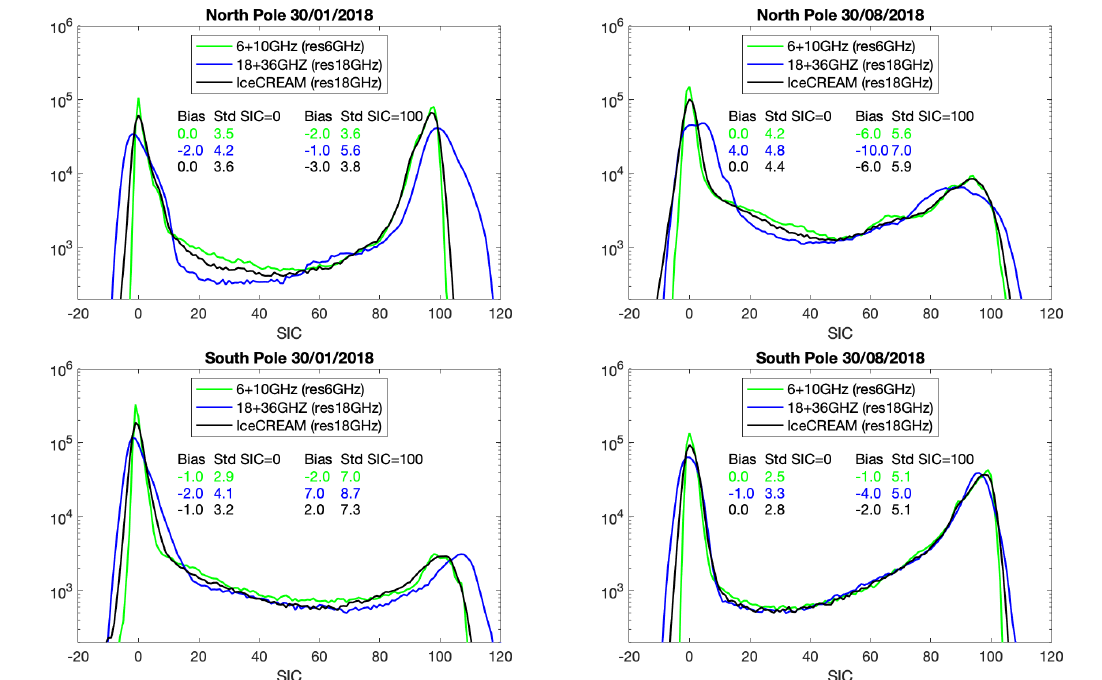
Figure 11. Histograms of our SIC estimates, for the north (top) and the south (bottom) polar regions, for 30 January 2018 (left), and for 30 August 2018 (right), for the 6+10GHz, the 18+36GHz, and the IceCREAM algorithms. A logarithmic scale is used for the y-axis. For SIC at 0% and SIC at 100%, the bias and the std are indicated for each algorithm, with the same color code. See the text for more